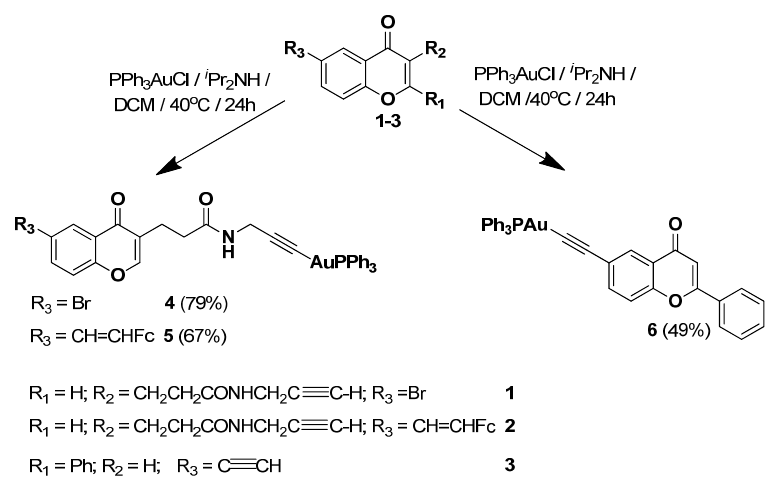
Figure 2. Ortep drawing of 6A at 50% probability ellipsoids with hydrogen atoms omitted for clarity, only one independent molecule being shown.